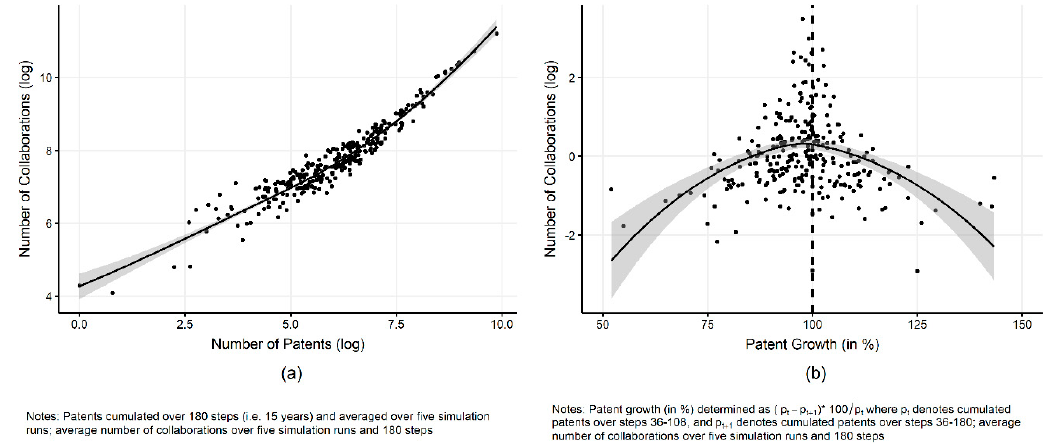
Figure 6. Relationship between number of collaborations and knowledge output (patents)